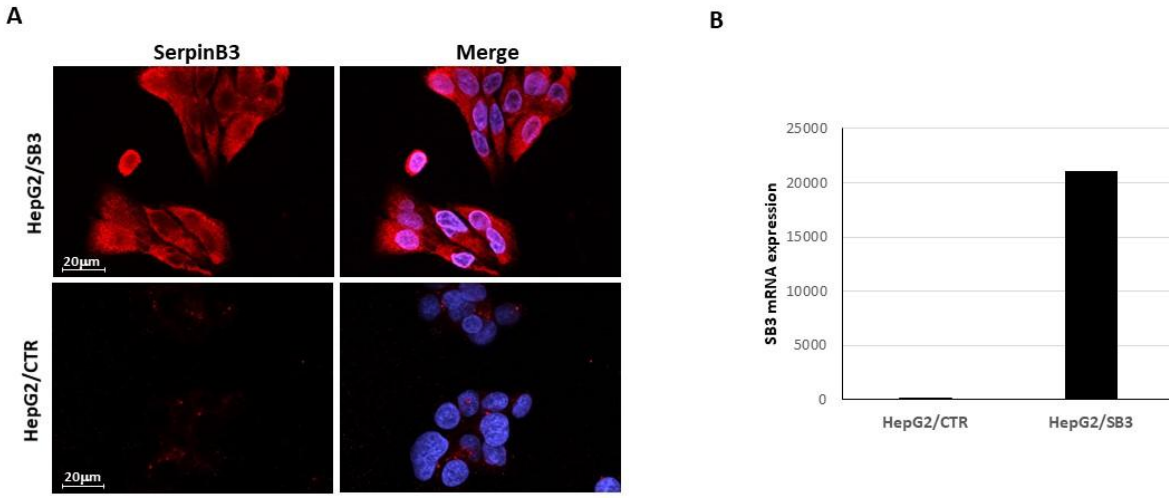
Figure 1. Example of SerpinB3 expression. ( A ) Representative immunofluorescence analysis of SerpinB3 expression in a SerpinB3 transfected HepG2 cell clone (HepG2/SB3) and in an empty vector transfected HepG2 cell clone (HepG2/CTR) used for EV preparation. The cells were immunostained with anti-SerpinB3 antibody (red) and the nuclei were counter- stained with DAPI (blue). ( B ) Analysis of SerpinB3 (SB3) transcripts in the corresponding clones by quantitative real-time PCR (Q-PCR). The relative expression of SB3 mRNA is expressed by calculating 2- ∆ Ct. The experiment was performed in triplicate.